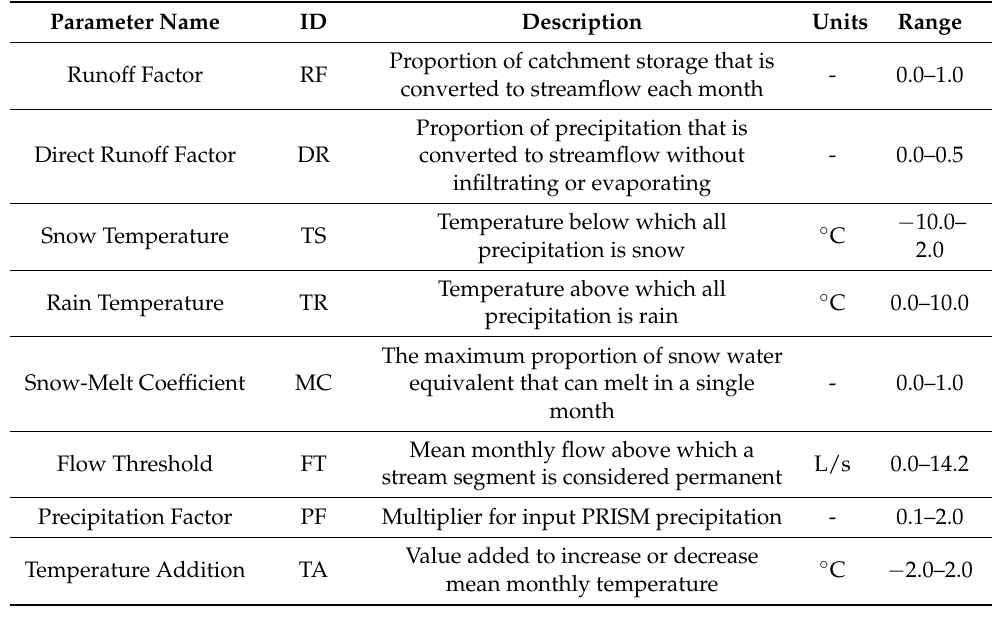
Table 1. Parameters assessed in sensitivity analysis and calibration of the monthly water balance model.